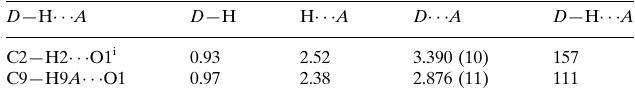
Hydrogen-bond geometry (A˚ , (cid:2)